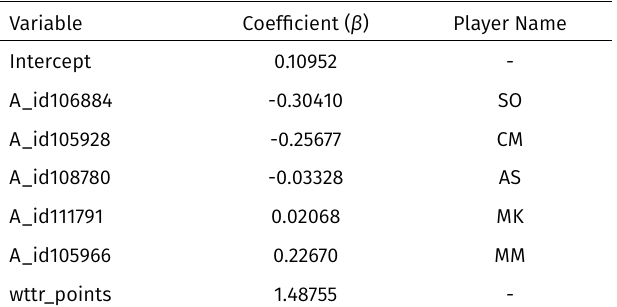
Table 5. Regression coefficients for the selected variables by the LASSO